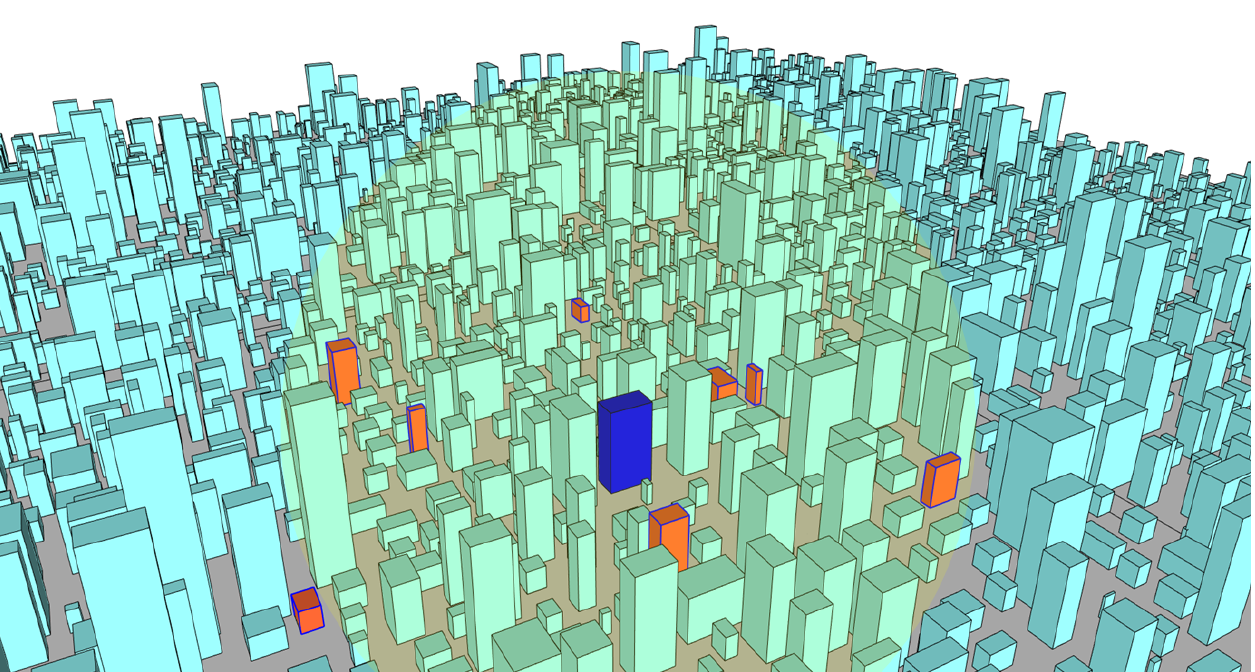
linearly each time the number of nearest neighbours increased.